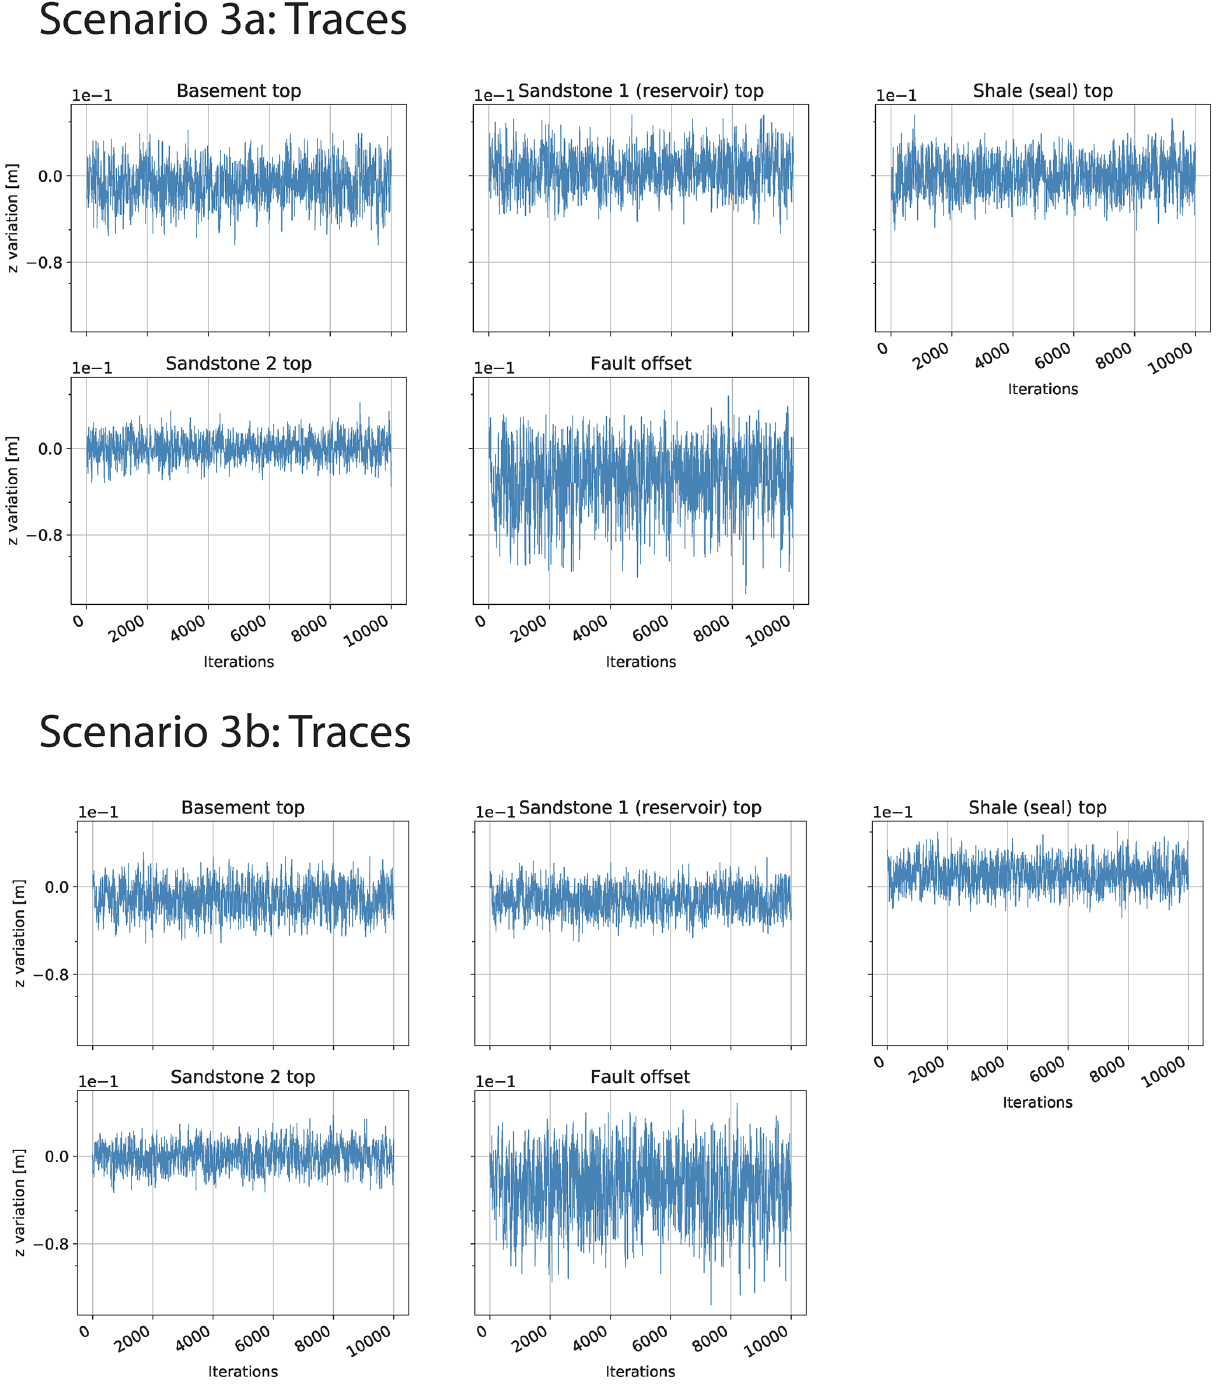
Figure C1. Geweke plots and traces for Scenarios 2a to